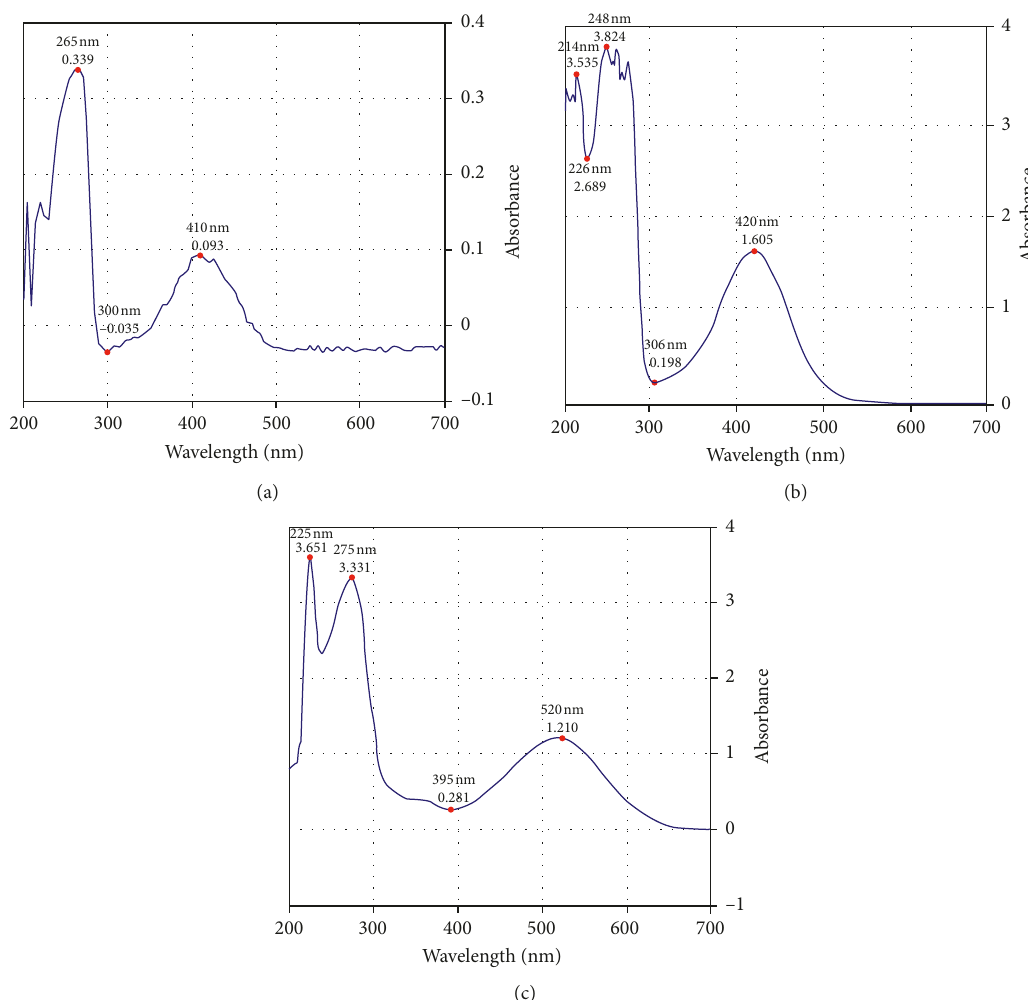
Figure 2: UV spectra for plumbagin in different pH media. (a) Plumbagin in methanol. Absorption occurs at 265 nm ( λ (b) Plumbagin in acidified methanol. Absorption takes place at 248 nm ( λ max ) and 420 nm from hypsochromic shift. (c) Plumbagin in basified methanol. Absorption takes place at 275 nm ( λ max ) and 520 nm from bathochromic shift.